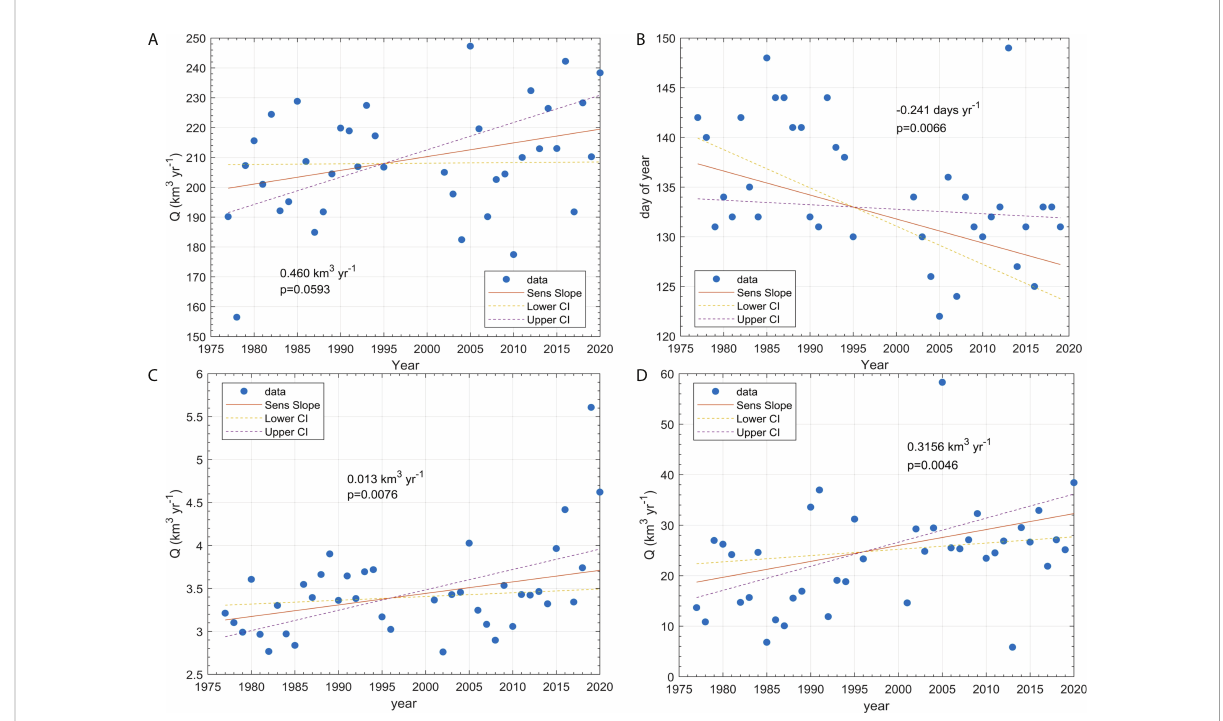
FIGURE 9 Mann-Kendall analysis of hydrographic trends at Pilot Station, AK from 1976-2020. The trend lines are shown in red and the upper and lower con fi dence intervals of the trends are represented by the dotted lines. The magnitude of the slope derived from the analysis and its corresponding p- value are presented on each graph for (A) annual discharge, (B) freshet start date, (C) total volume calculated for April, and (D) total volume calculated for